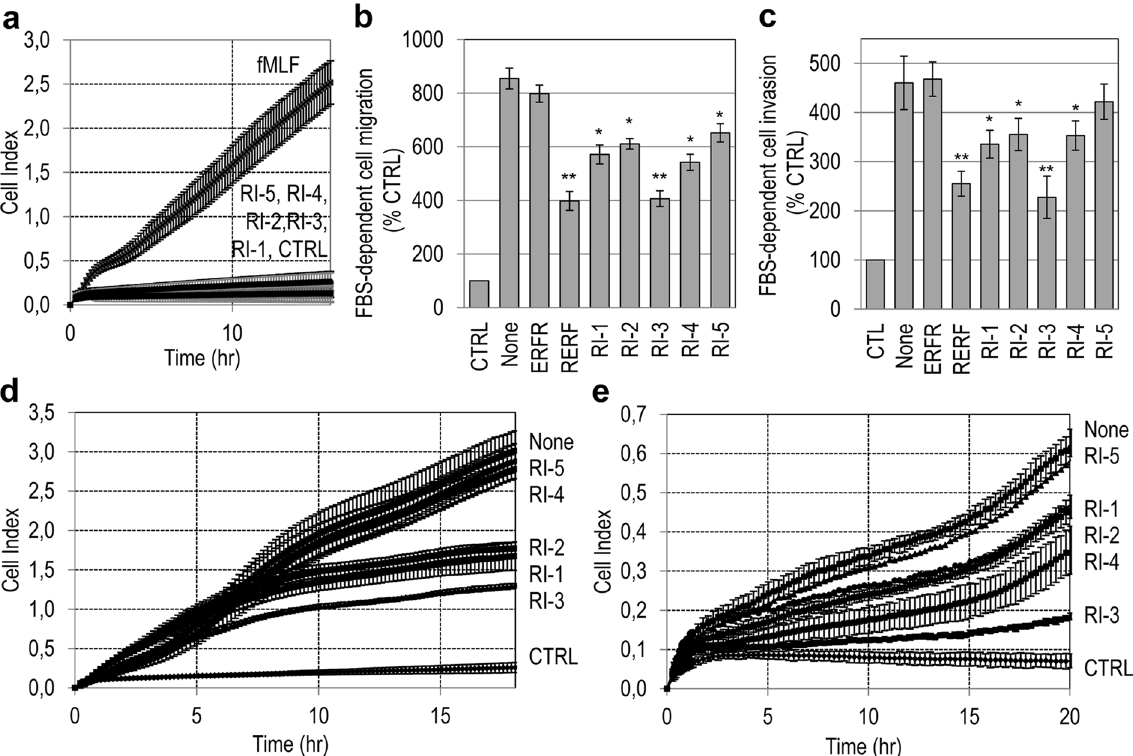
Figure 2. The Retro-Inverso peptides inhibit cell migration and matrigel invasion. ( a ) Human fibrosarcoma HT1080 cell migration toward 10 nM fMLF or 10 nM the indicated peptides, monitored for 18 hr by the xCELLigence system Data represent mean ± SD from a quadruplicate experiment. ( b,c ) HT1080 cells were allowed to migrate ( b ) or invade matrigel ( c ) toward 10% FBS (None) or 10% FBS plus 10 nM of the indicated peptides in Boyden chambers for 4 hr ( b ) or 6 hr ( c ). Basal values assessed in the absence of FBS (CTRL) were taken as 100% and all values were reported relative to that. Data are the means ± SD of three independent experiments, performed in triplicate. * Statistical significance calculated against None, with * P < 0.01 , ** P < 0.001 . ( d , e ) HT1080 cell migration ( d ) or matrigel invasion ( e ) toward serum-free medium (CTRL), 10% FBS without (None) or with 10 nM of the indicated peptides, monitored for 18 hr ( d ) or 20 hr ( e ) by the xCELLigence system. Data represent mean ± SD from a quadruplicate experiment.